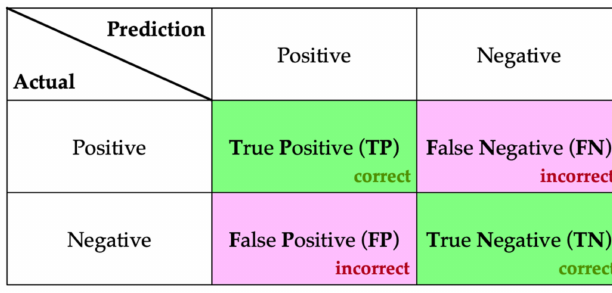
Figure 13. Confusion matrix.